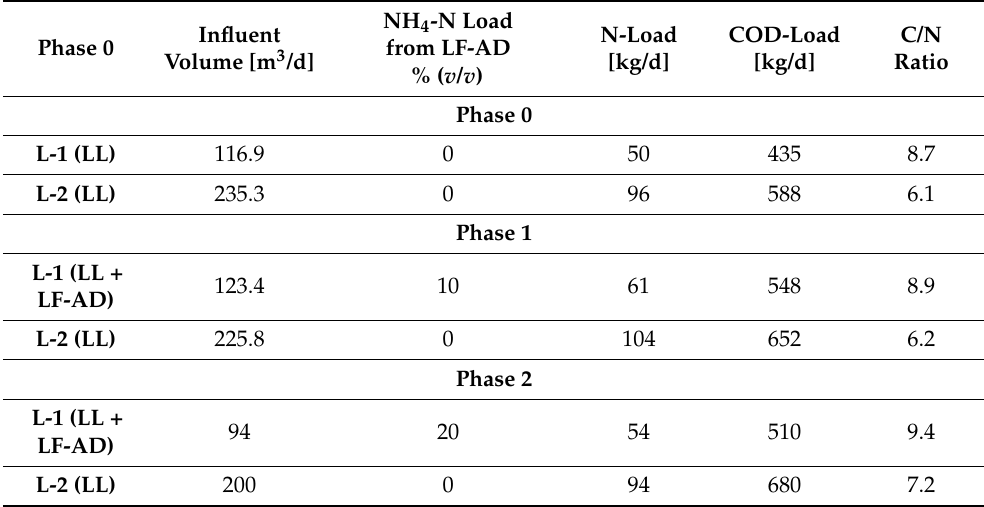
Table 4. The three phases of the study and the influent volumes, N-loads, COD loads, and C/N ratios of the respective